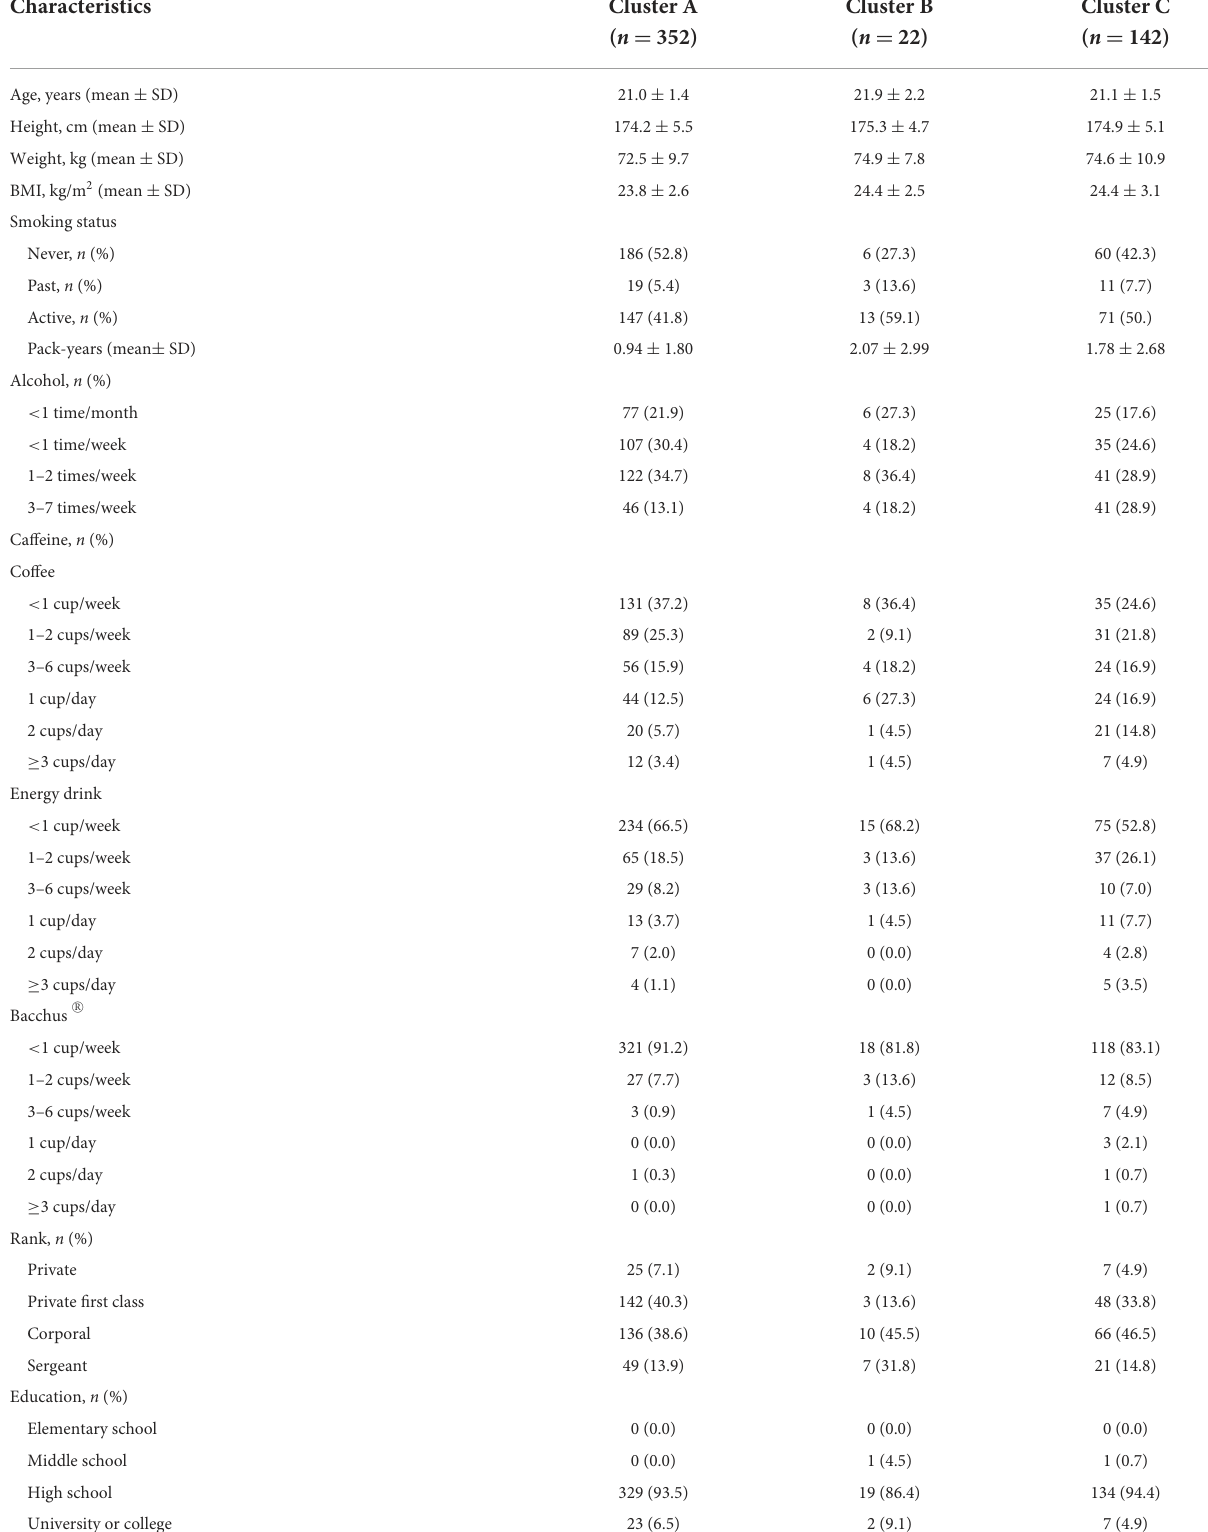
TABLE 3 Patient characteristics in each test set cluster.